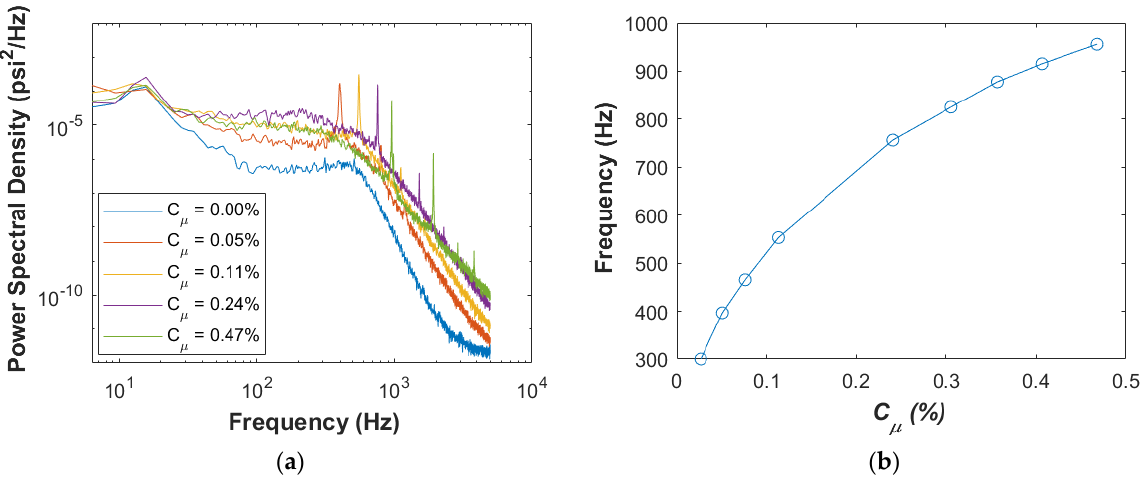
Figure 8. Variation of the fluidic oscillator frequency with respect to momentum coefficient: ( a ) power spectral density from port#1; ( b ) peak oscillation frequency.